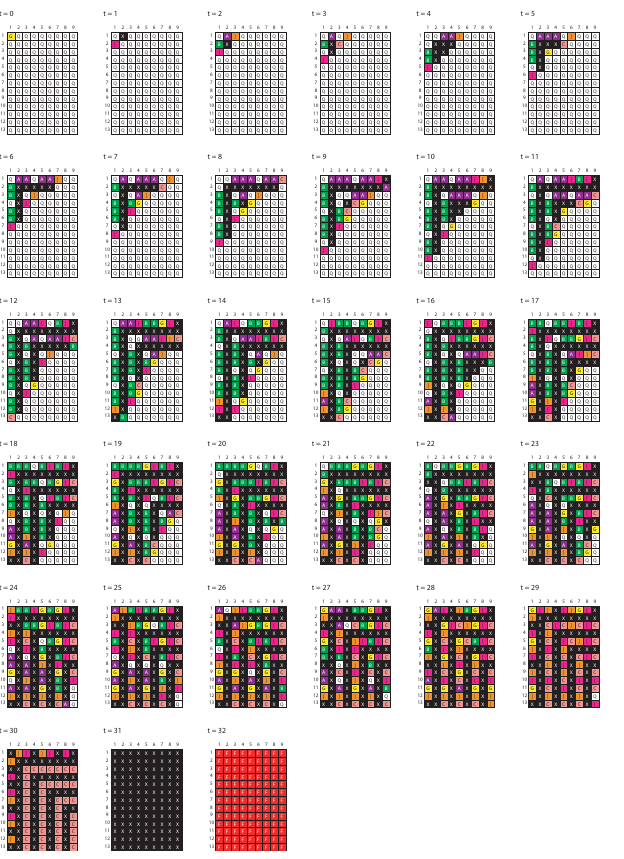
Fig. 6. Snapshots of the optimum-time nine-state synchronization process on a 13 × 9